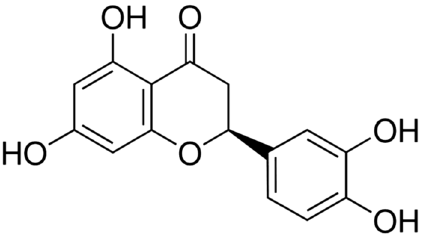
Fig. 20 Structure of syringic acid (4-hydroxy-3,5-dimethoxybenzoi- cacid)